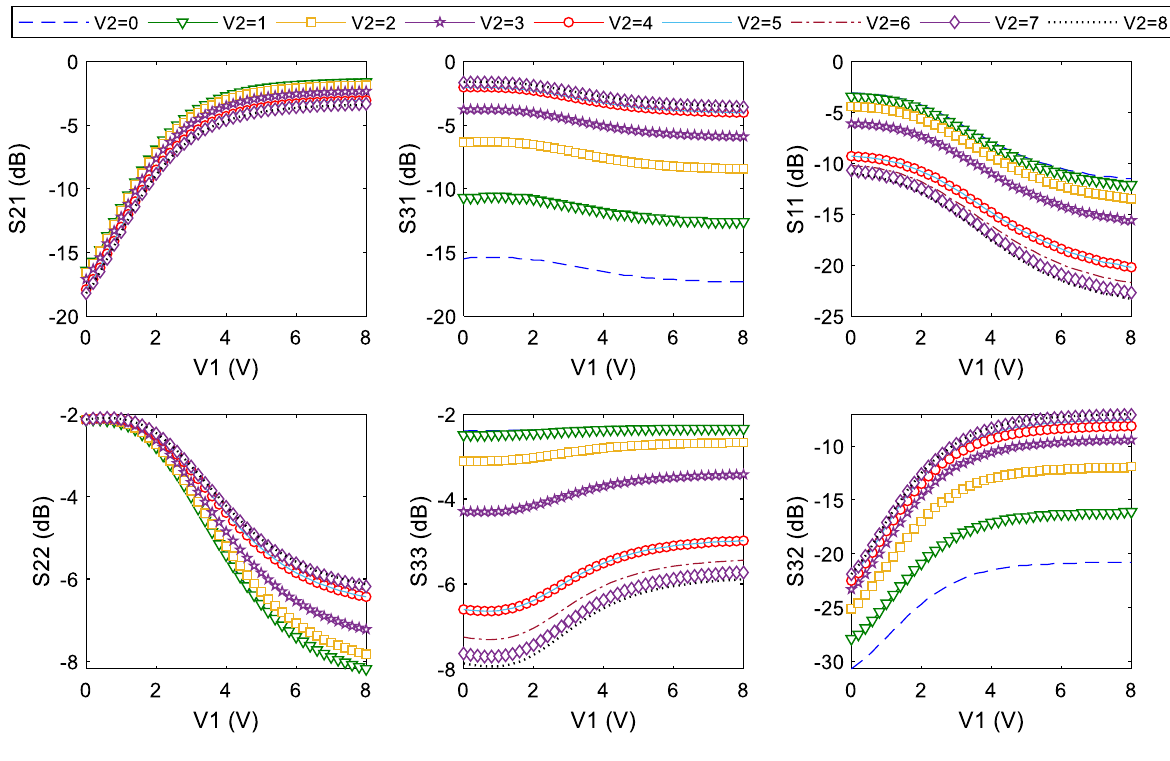
Figure 13. Wide range simulation S-parameters results of the proposed TWPD (first design).